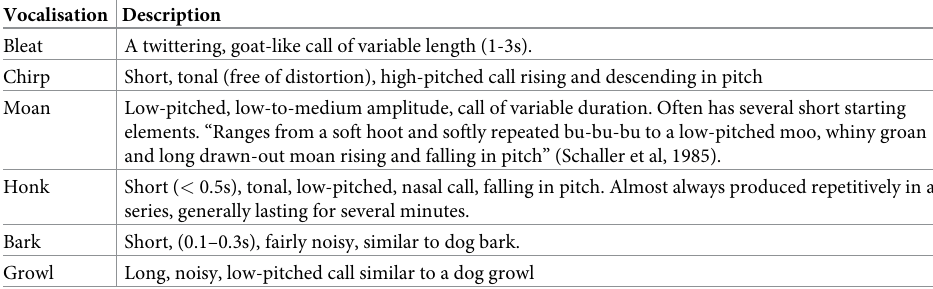
Table 2. Ethogram of male giant panda vocal behaviour. Exemplars of the different call types are provided as sup- plementary material. Refer to methods section for details about the 1–0 sampling protocol. Vocalisation Description Bleat A twittering, goat-like call of variable length (1-3s). Chirp